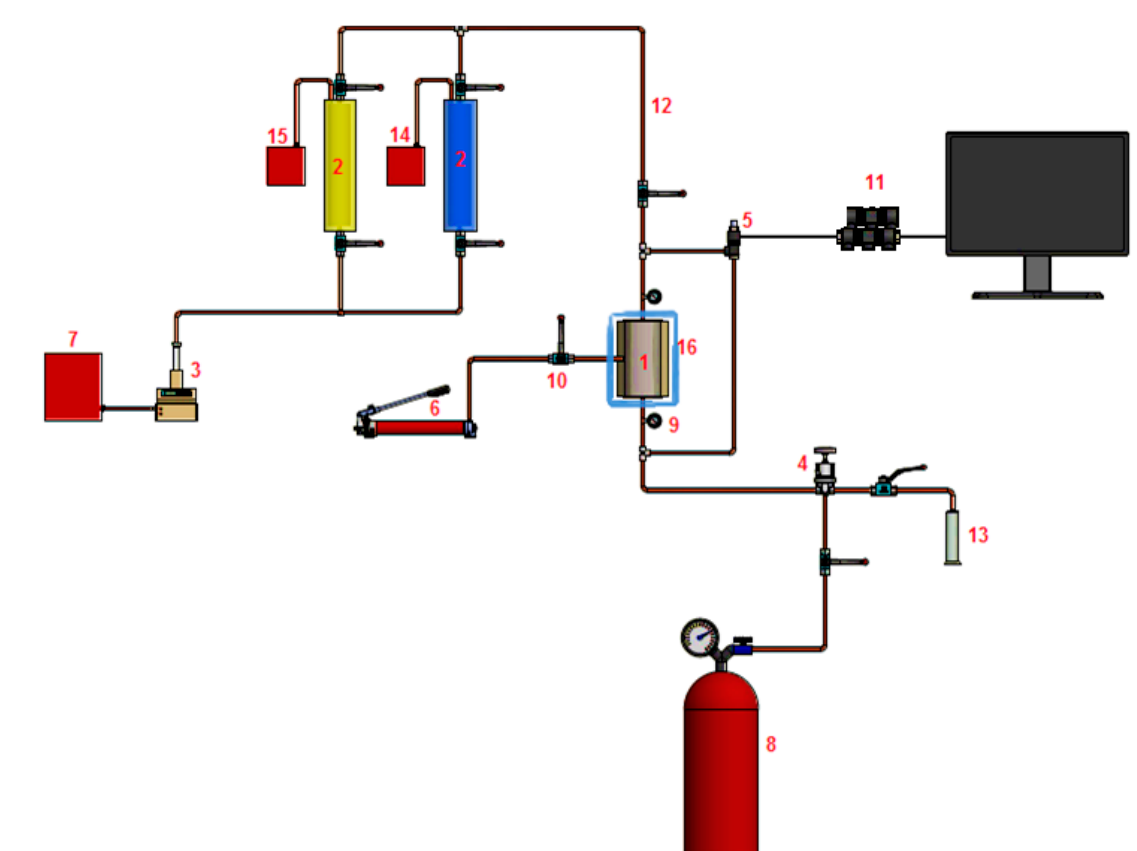
Figure 1. Schematic diagram of designed experimental core flooding rig showing the fluid flow direction and the component parts [1. Core holder, 2. Accumulators, 3. Injection pump, 4. Back pressure regulator, 5. Pressure transducer, 6. Hand pump, 7. Refill tank, 8. Gas cylinder, 9. Pressure gauges, 10. Valves, 11. Data acquisition system, 12. Tubing, 13. Effluent collector, 14. Oil tank, 15. Brine tank and 16. Heating jacket] (adapted from [24]).